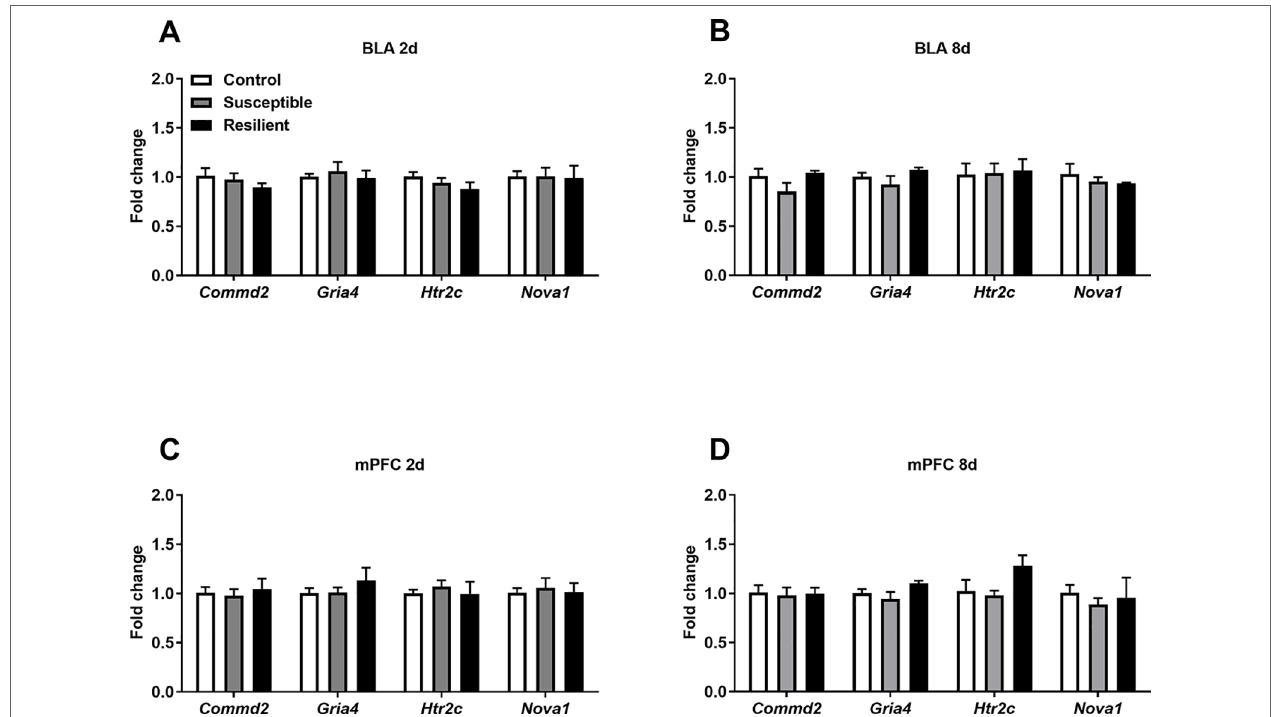
FIGURE 3 | Expression levels of differentially edited transcripts are unaltered following CSDS. No significant changes in the expression levels of several differentially edited transcripts were observed with the BLA (A) or mPFC (B) at 2 days or within the BLA (C) or mPFC (D) 8 days following the final defeat. Control 2 days, n = 7; susceptible 2 days, n = 10; resilient 2 days, n = 4; control 8 days, n = 5–7; susceptible 8 days, n = 7; resilient 8 days, n =